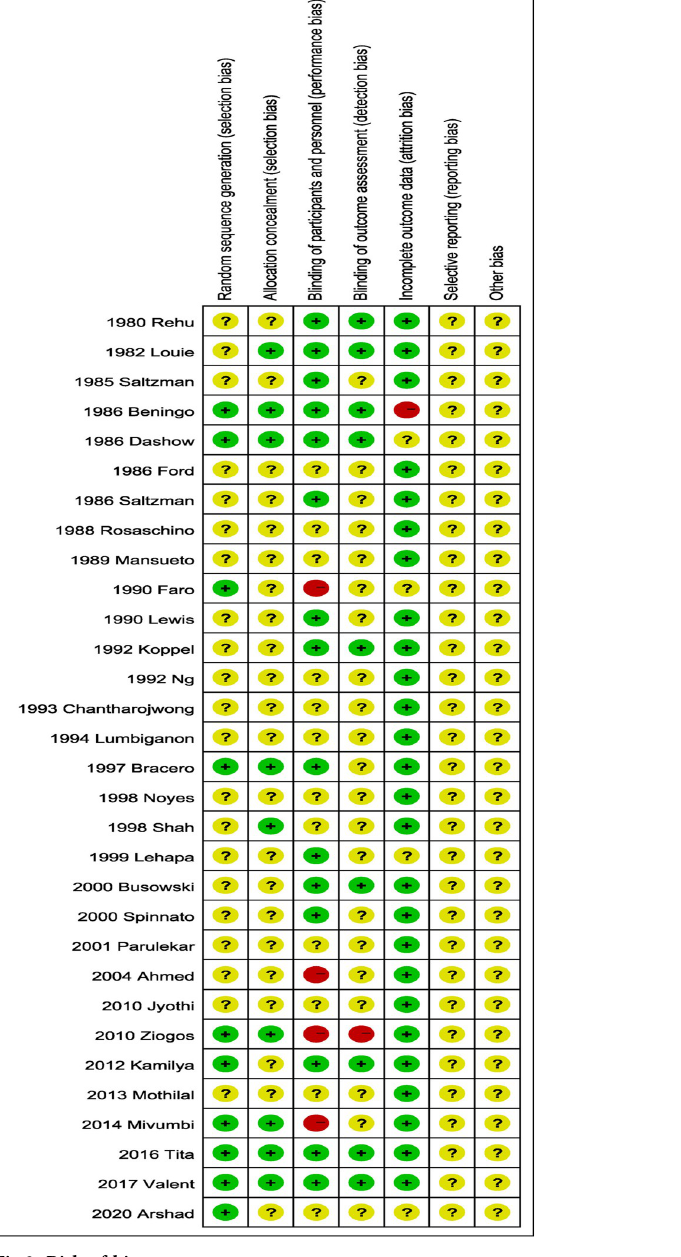
Fig 2. Risk-of-bias